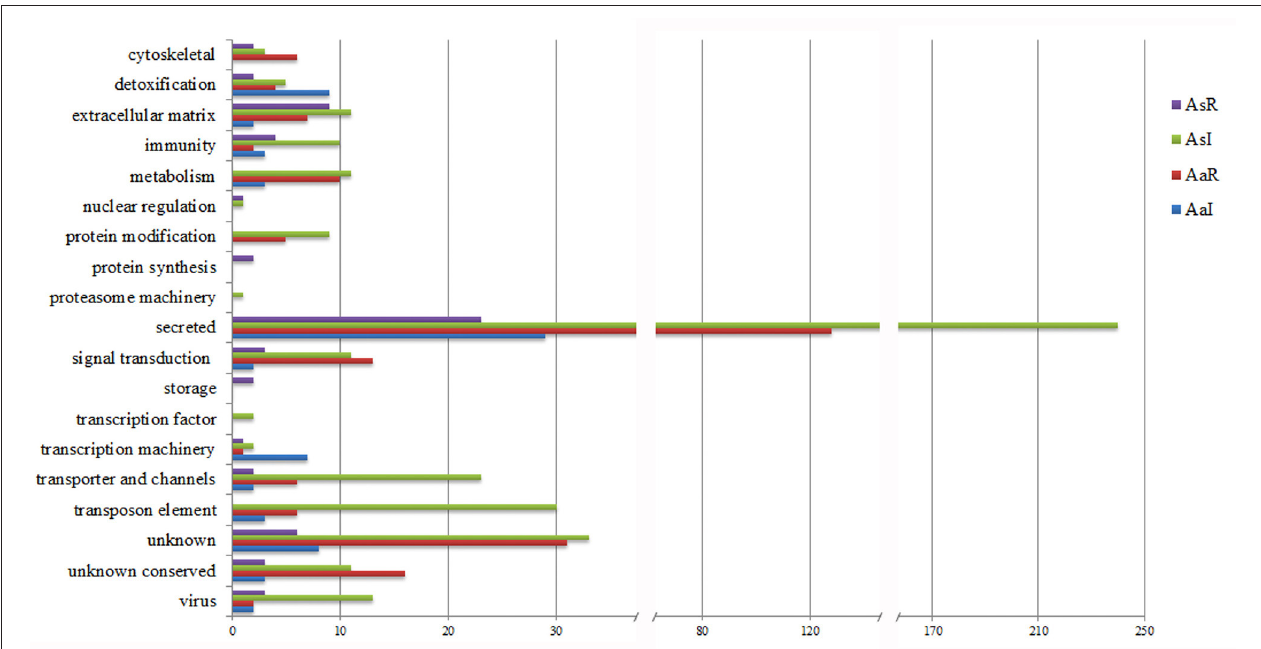
FIGURE 1 | Functional classification of CDSs differentially expressed in the midgut of R. rickettsii -infected ticks. AsR, downregulated CDSs of A. sculptum ; AsI, upregulated CDSs of A. sculptum ; AaR, downregulated CDSs of A. aureolatum ; AaI, upregulated CDSs of A. aureolatum .